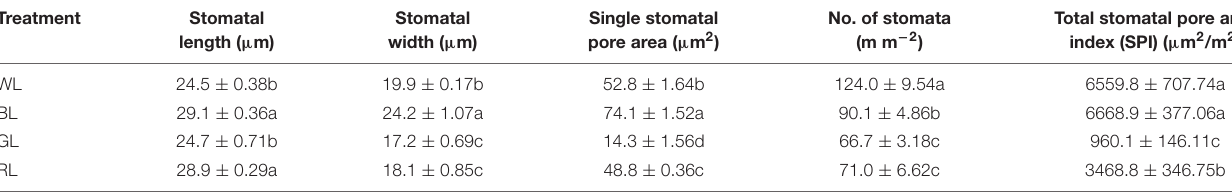
TABLE 3 | Stomata index of C. paliurus leaves under different LED light treatments (Means ± SD). Treatment